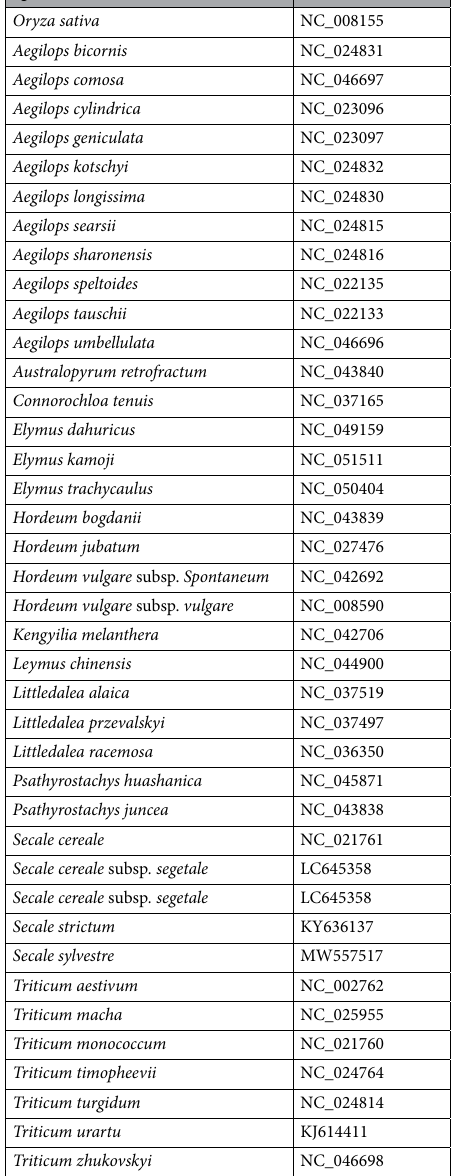
Table 4. List of species used in phylogenetic studies. Species names arranged